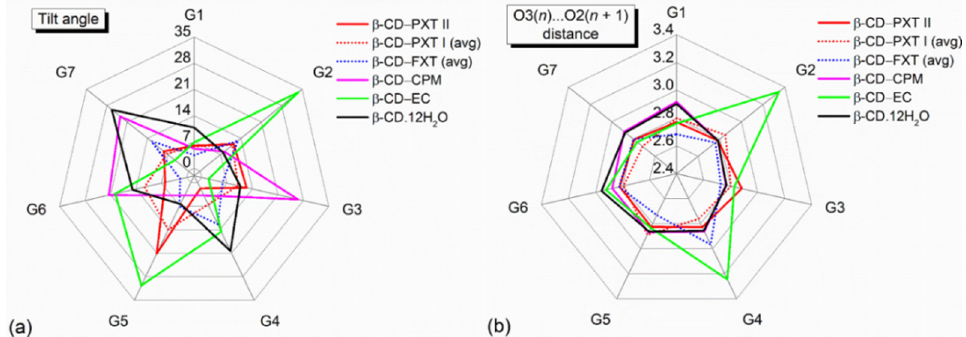
Figure 2. Radar plots of ( a ) tilt angles and ( b ) O3( n )···O2( n + 1) distances of the β-CD glucose units (G1–G7) depicting the host conformational changes upon inclusion of the halogen-containing antidepressants, clomipramine (CPM) HCl [32], PXT HCl (form II), PXT base (form I [35]) and fluoxetine (FXT) HCl [34], of which the averages of two similar β-CD monomers in the β-CD dimer are shown. For comparison, data of the inclusion complex of β-CD–(–)-epicatechin (EC) [42] and the uncom- plexed β-CD·12H 2 O [40] are included; see also Table S2. Angles and distances are in ° and Å.